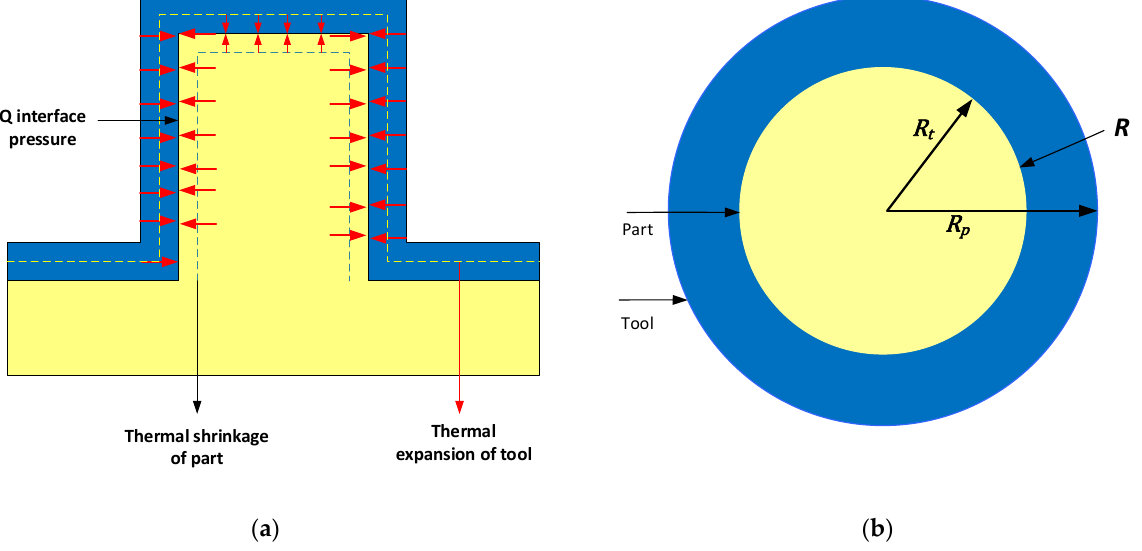
4 Pin Table 5. Injection moulding process parameters. Description